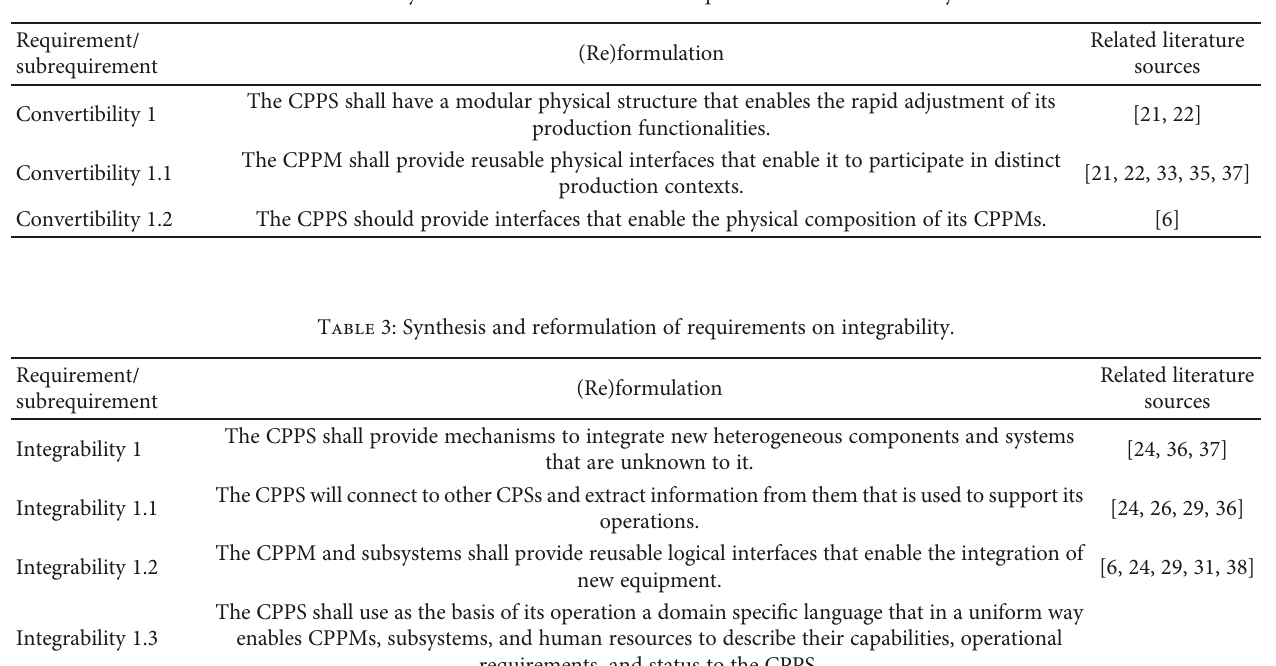
Table 2: Synthesis and reformulation of requirements on convertibility.